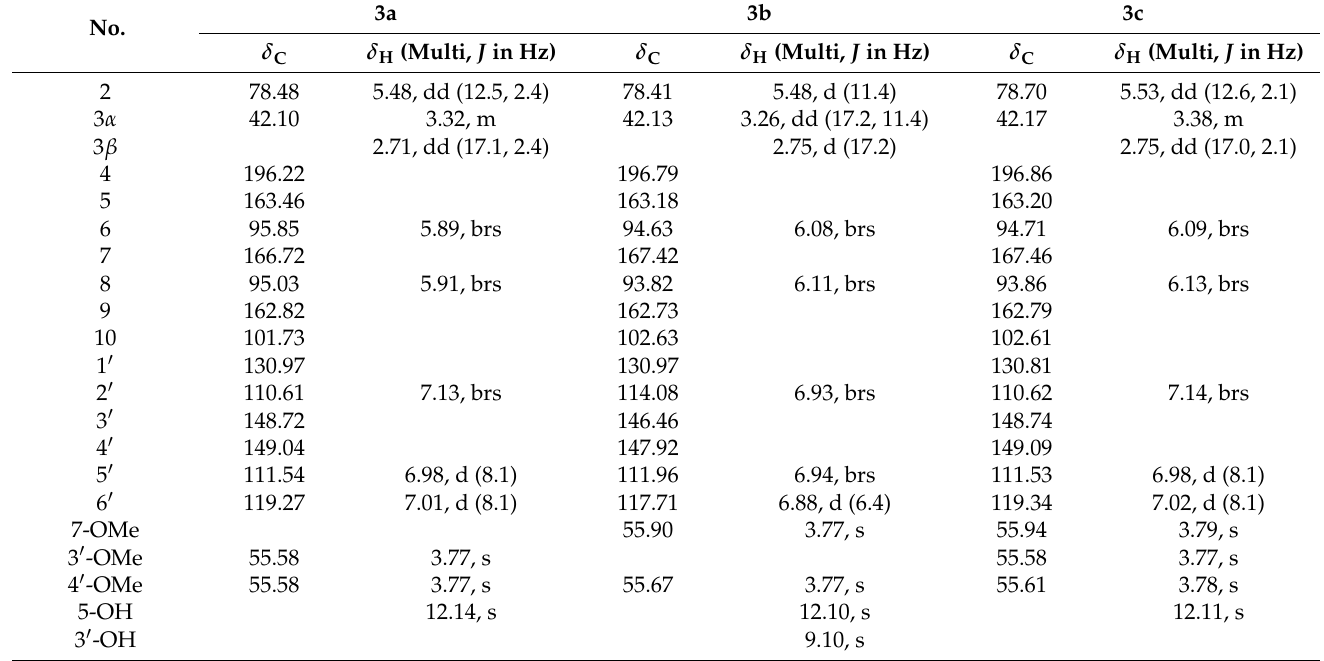
Table 3. 1 H (600 MHz) and 13 C NMR (150 MHz) data for 3a, 3b, and 3c in DMSO- d 6 .